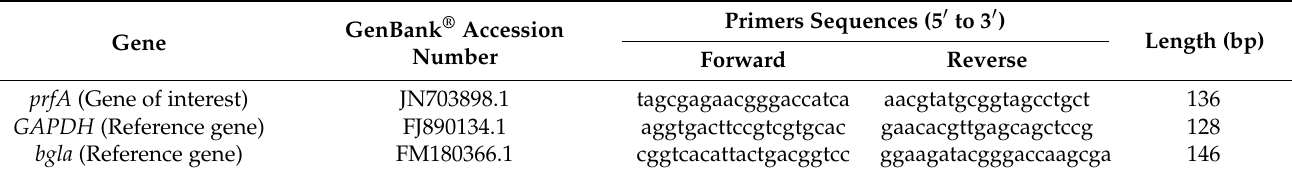
Table 1. List of primer sequences used in this